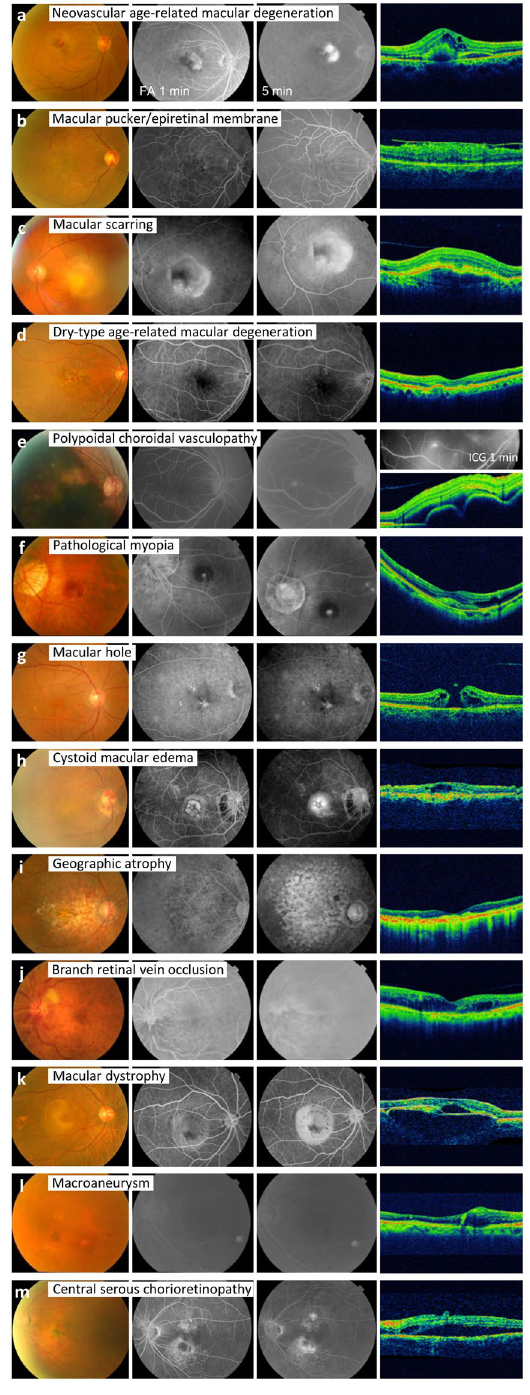
Figure 3. Representative fundus images for typical neovascular age-related macular degeneration ( a ) and other mimicking diseases that were rejected by the national health insurance system ( b–m ). FA, fluorescein angiography; ICG, indocyanine